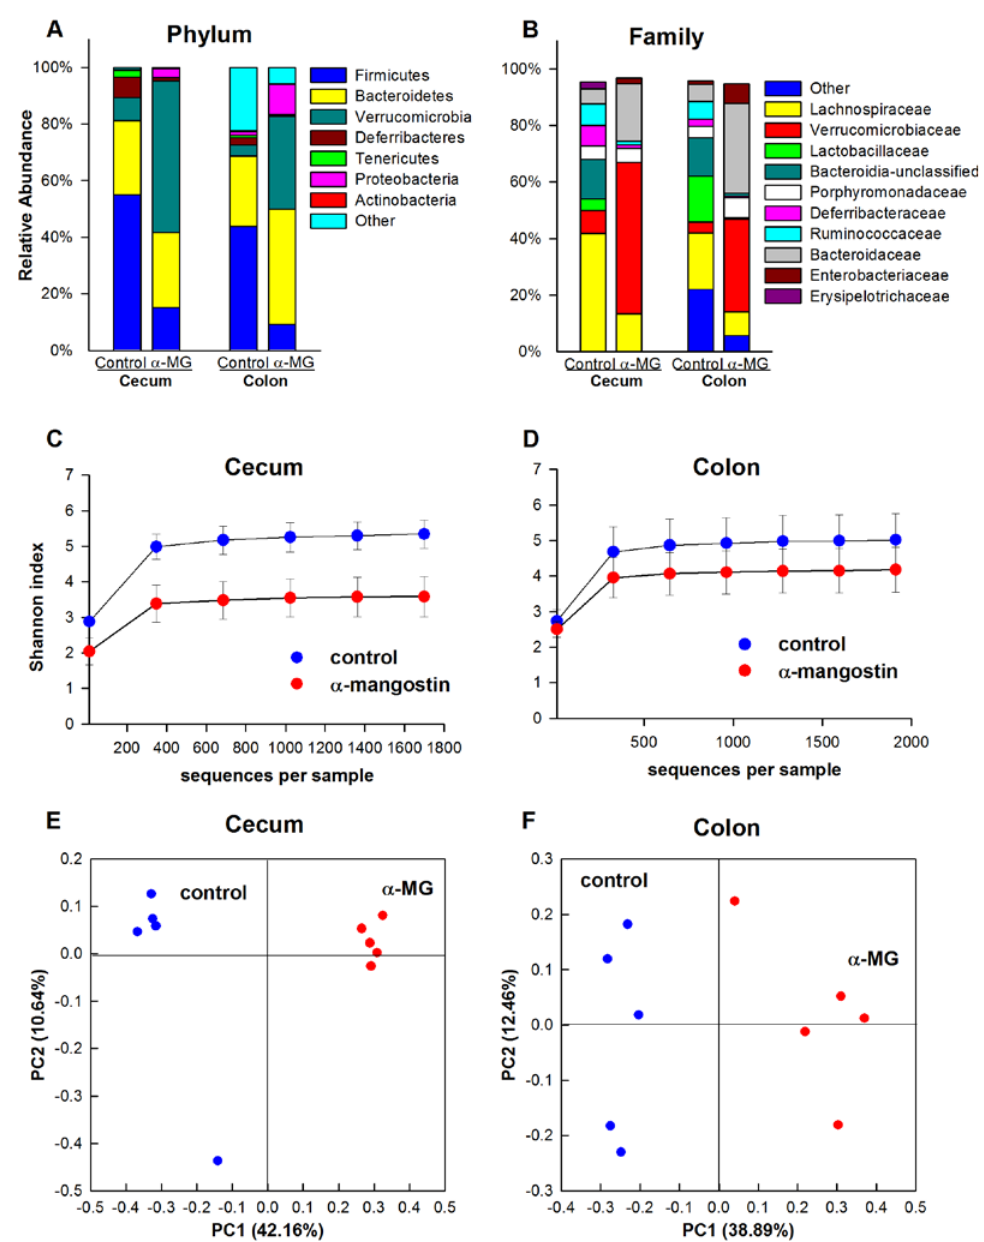
Figure 5. Dysbiosis is induced in colon and cecum of C3H mice fed diet with α-MG. Dietary α-mangostin (α-MG) changes the relative abundance of bacterial communities in the cecum and colon of C3H mice at the ( A ) phylum and ( B ) family levels. Mice fed α-MG had significantly lower α-diversity in ( C ) cecum but not in ( D ) colon. Panels E and F show principal coordinate analysis (PCoA) for cecum and colon, respectively. Samples in the α-MG group (red) cluster together and away from those in control group (blue). Data are for tissues from 5